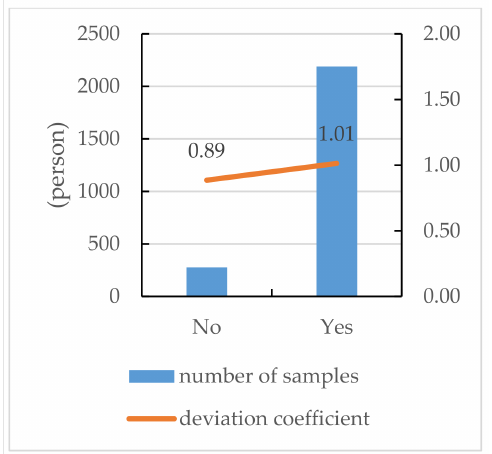
Figure 7. Deviation coefficient of agricultural machinery utilization rate grouped by skill